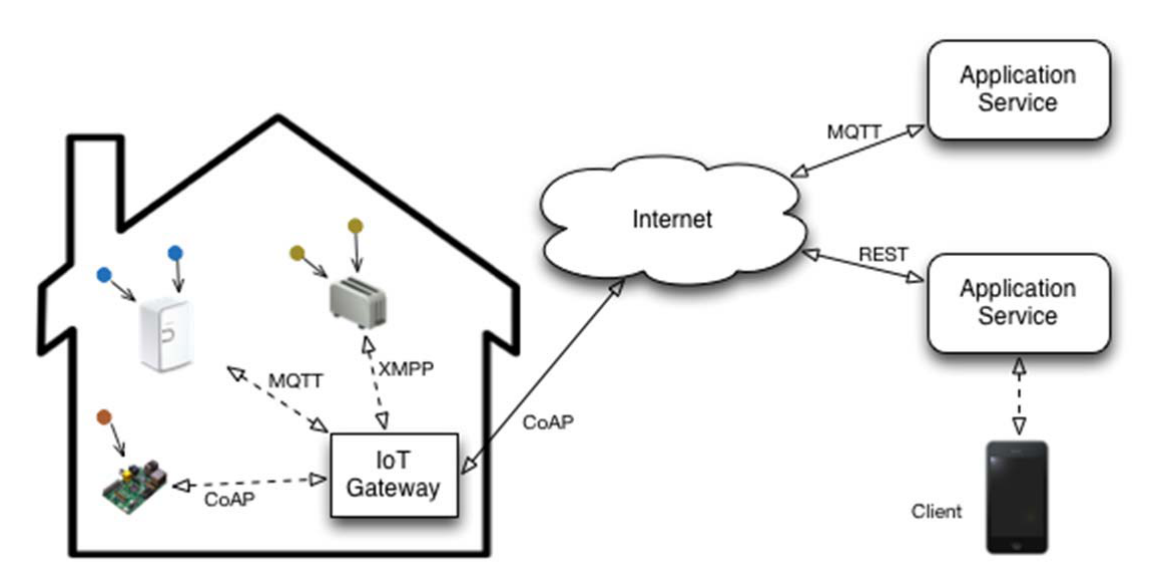
Figure 2. The main components of an IoT system